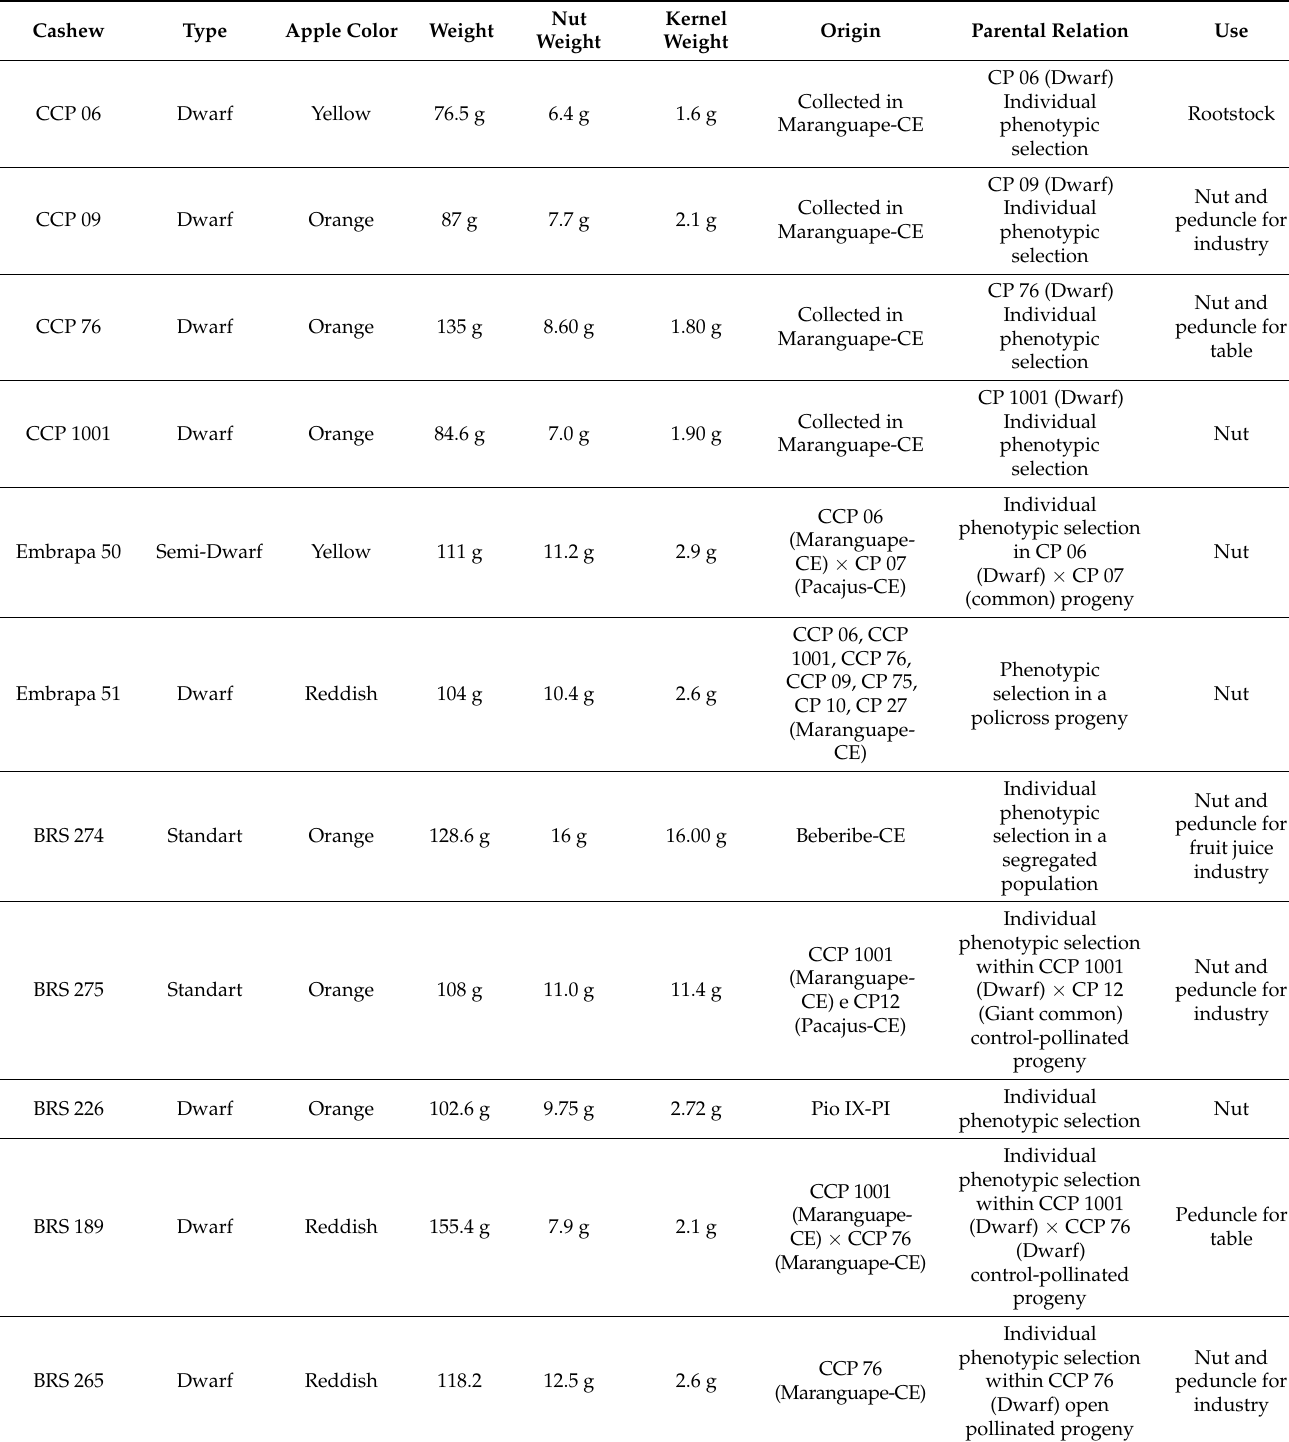
Table 2. Cashew Cultivar